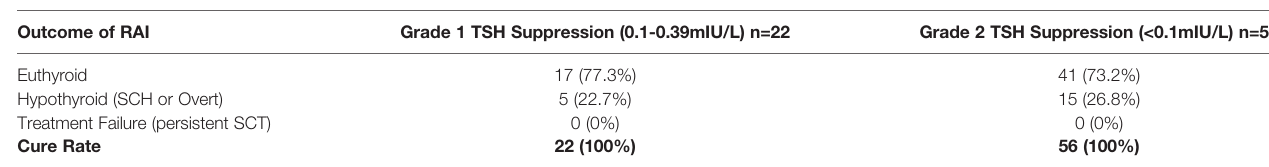
TABLE 5 | Post-RAI outcome classi fi ed by severity of TSH suppression. Outcome of